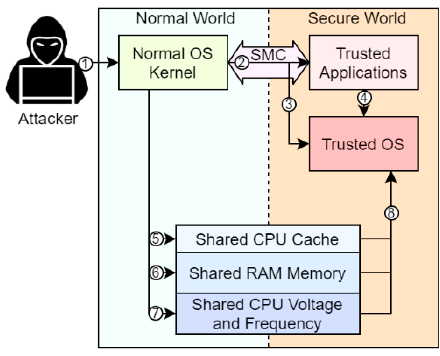
Figure 17. TrustZone attack paths.